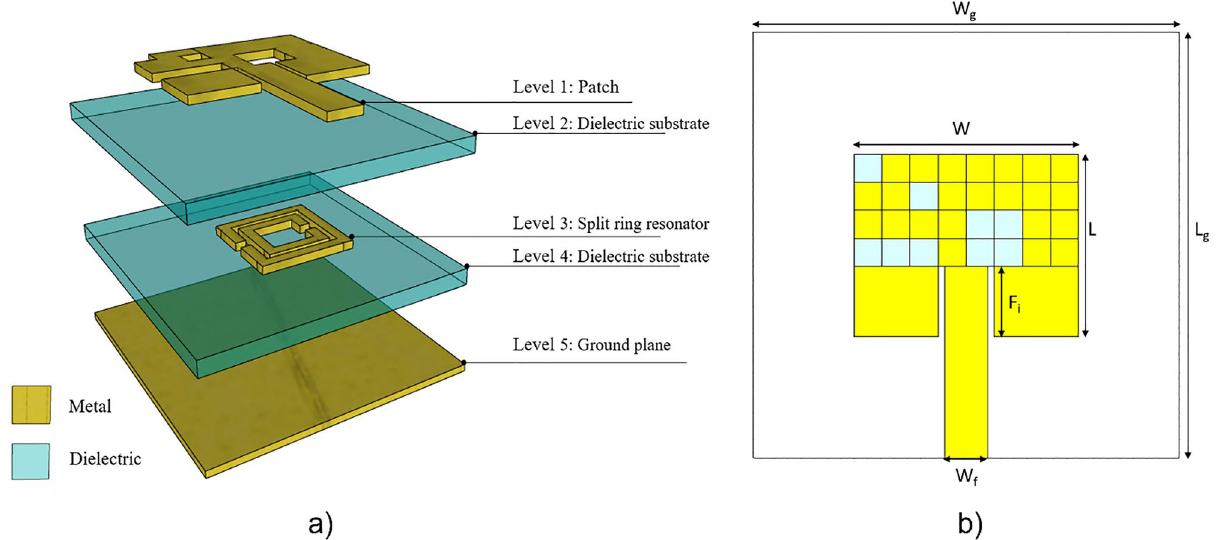
Figure 2. Sketches of the proposed antenna: ( a ) Exploded representation of the multilayer antenna, ( b ) top- view of the evolved patch antenna. Software used: Rhino 6, https:// www. rhino 3d. com/